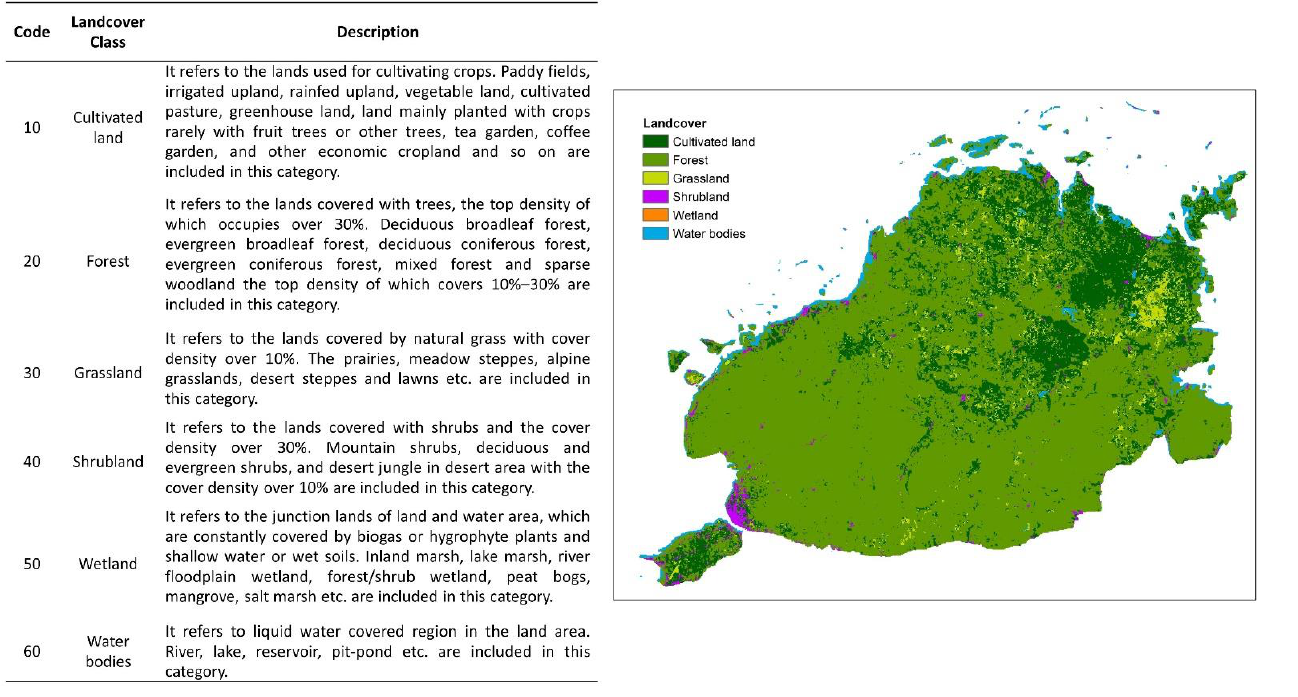
Figure A3. Details of the landcover in the study area.